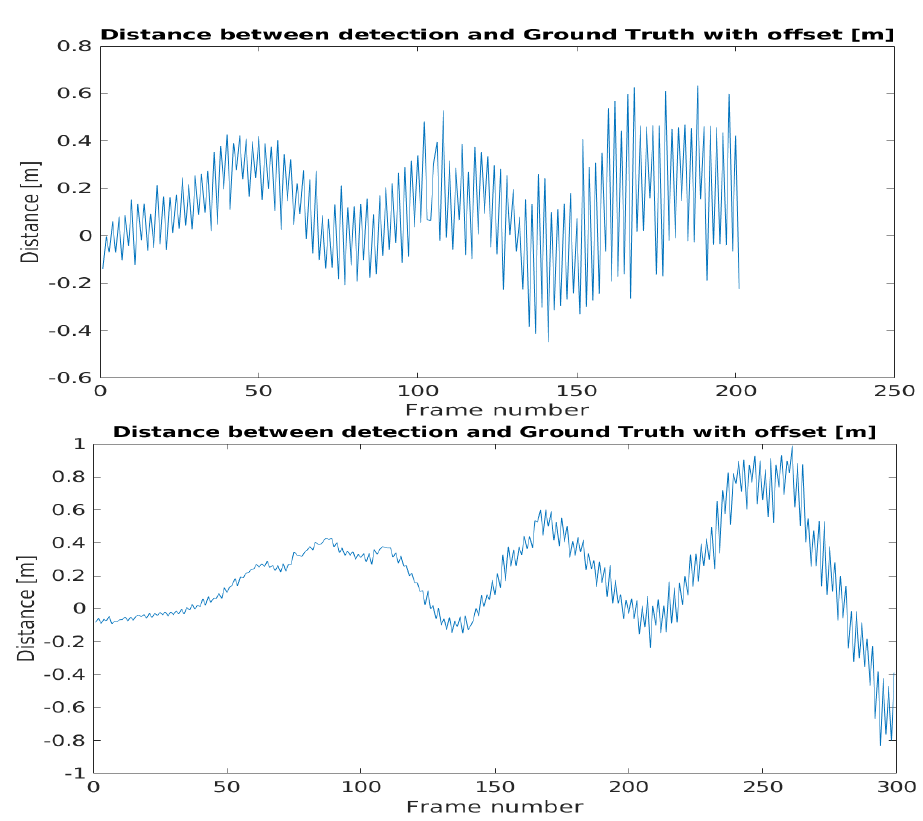
Figure 40. Distance differences in case of the BMW ( above ) and the Truck ( below